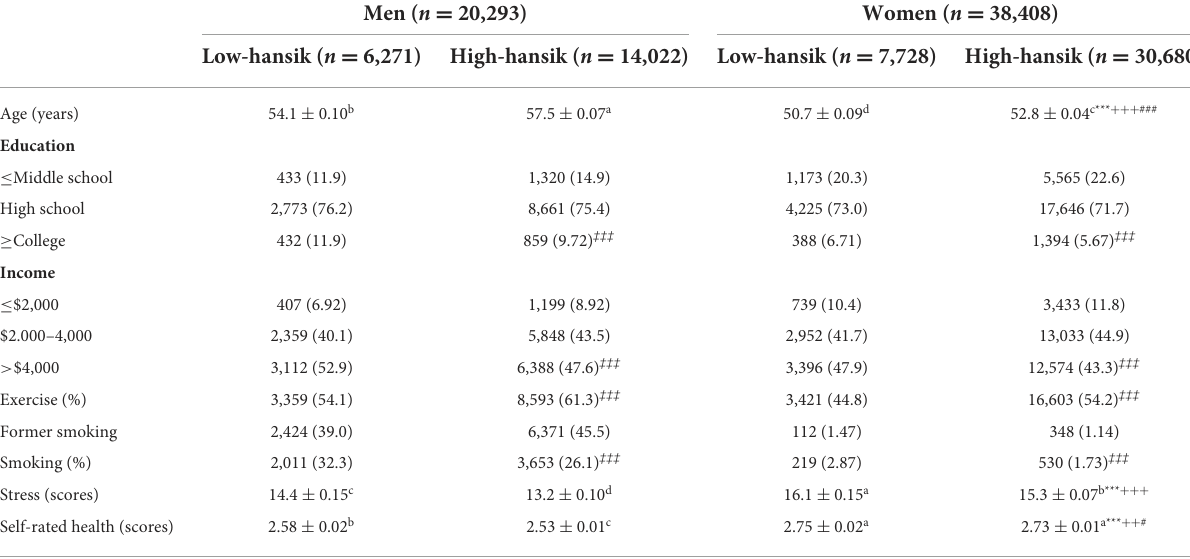
TABLE 2 Demographic and sociographic characteristics according to gender and hansik intake defined by the K diet -index